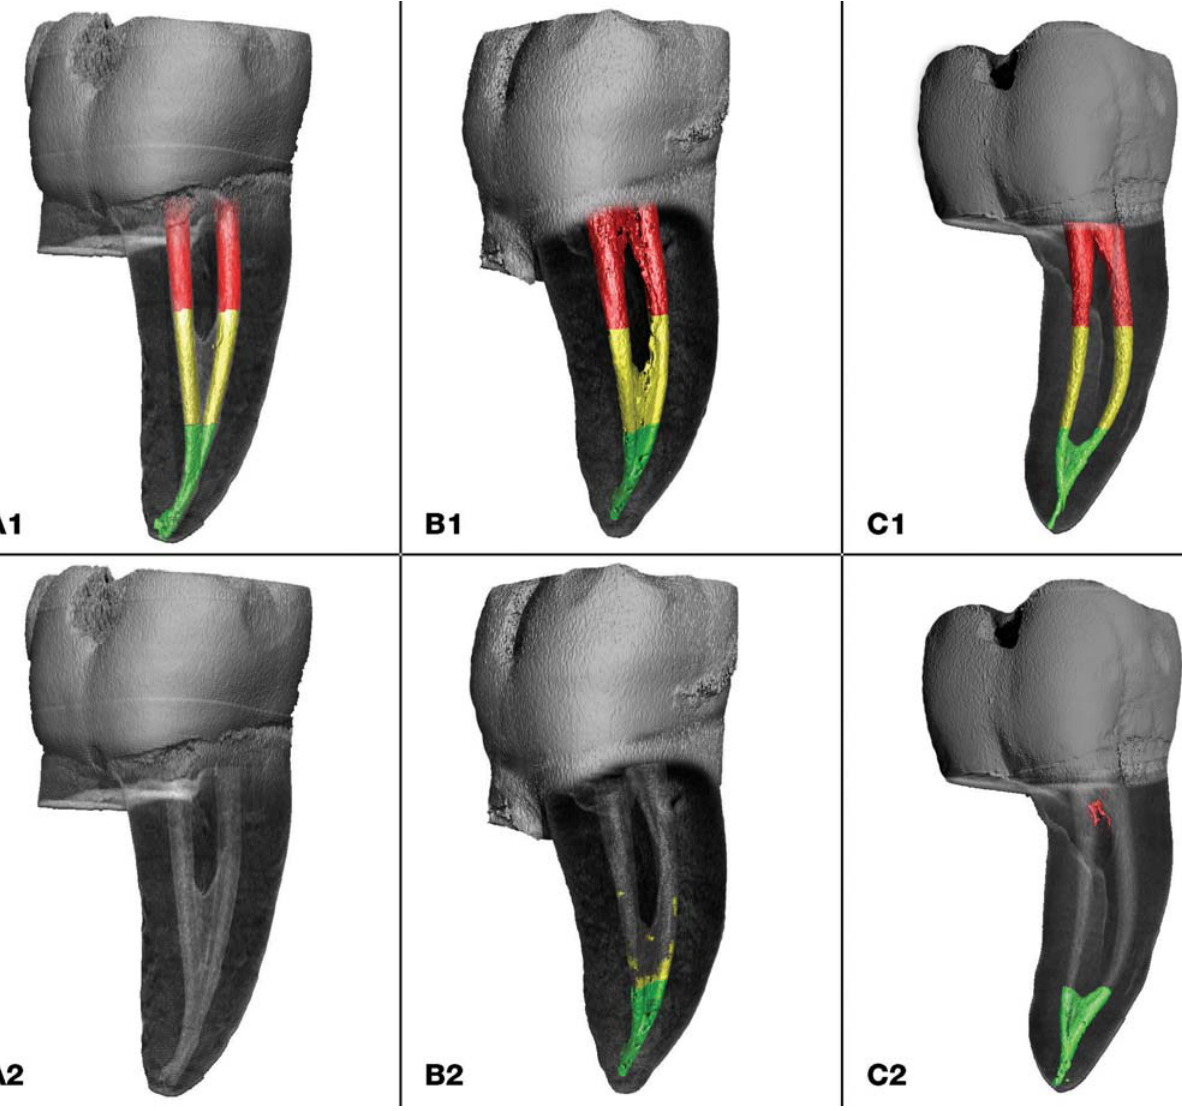
Figure 1- (cid:3)(cid:55)(cid:75)(cid:85)(cid:72)(cid:72)(cid:16)(cid:71)(cid:76)(cid:80)(cid:72)(cid:81)(cid:86)(cid:76)(cid:82)(cid:81)(cid:68)(cid:79)(cid:3)(cid:85)(cid:72)(cid:70)(cid:82)(cid:81)(cid:86)(cid:87)(cid:85)(cid:88)(cid:70)(cid:87)(cid:76)(cid:82)(cid:81)(cid:86)(cid:3)(cid:82)(cid:73)(cid:3)(cid:80)(cid:72)(cid:86)(cid:76)(cid:68)(cid:79)(cid:3)(cid:85)(cid:82)(cid:82)(cid:87)(cid:86)(cid:3)(cid:82)(cid:73)(cid:3)(cid:80)(cid:68)(cid:81)(cid:71)(cid:76)(cid:69)(cid:88)(cid:79)(cid:68)(cid:85)(cid:3)(cid:80)(cid:82)(cid:79)(cid:68)(cid:85)(cid:86)(cid:3)(cid:90)(cid:76)(cid:87)(cid:75)(cid:3)(cid:58)(cid:72)(cid:76)(cid:81)(cid:72)(cid:3)(cid:55)(cid:92)(cid:83)(cid:72)(cid:3)(cid:44)(cid:44)(cid:3)(cid:70)(cid:68)(cid:81)(cid:68)(cid:79)(cid:3)(cid:70)(cid:82)(cid:81)(cid:191)(cid:74)(cid:88)(cid:85)(cid:68)(cid:87)(cid:76)(cid:82)(cid:81)(cid:86)(cid:3) illustrating remaining Ca(OH) in the different canal thirds (coronal – red; middle – yellow; apical – green) before (A1–C1) 2 and after irrigation protocols (A2) PIPS, (B2) PUI, (C2) Table 1- Median (interquartile range) percentage of remaining Ca(OH) after irrigation with different techniques for canal 2 thirds